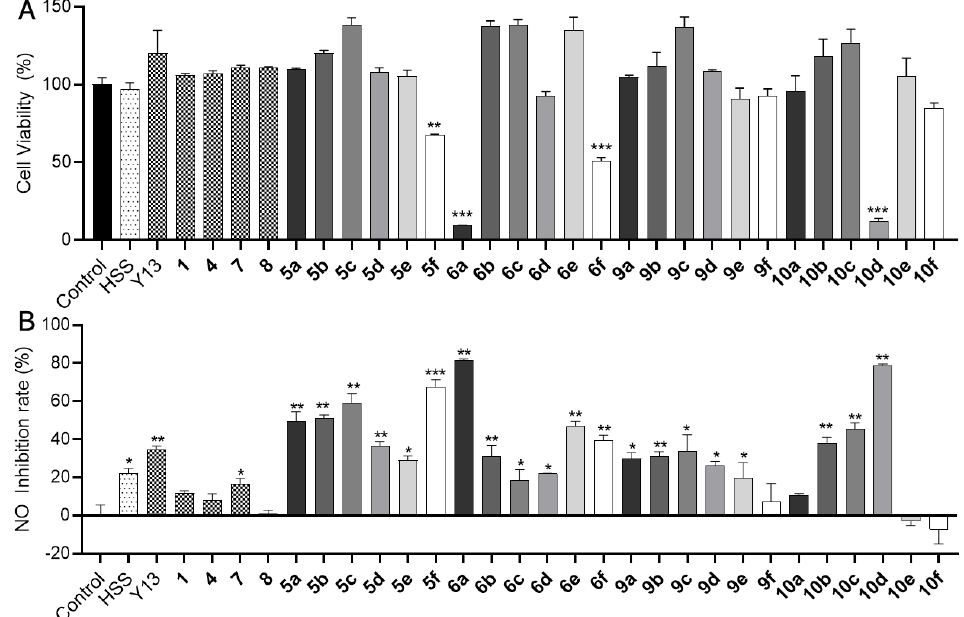
Figure 2. Inhibitory effects of 12-dehydropyxinol derivatives on LPS-triggered NO production in RAW264.7 macrophages : ( A ) Effect of 12-dehydropyxinol derivatives on cell survival and ( B ) LPS- triggered NO production. After pretreatment with test compounds (20 μM) for 2 h, the macrophages were treated with LPS (1 μg/mL) and further incubated for 24 h. Cell viability and nitrite concentra- tions were determined using MTT assays and Griess reaction, respectively. Data are expressed as the means ± SD ( n = 3): * p < 0.05, ** p < 0.01, *** p < 0.001 vs. control. HSS: hydrocortisone sodium succinate.